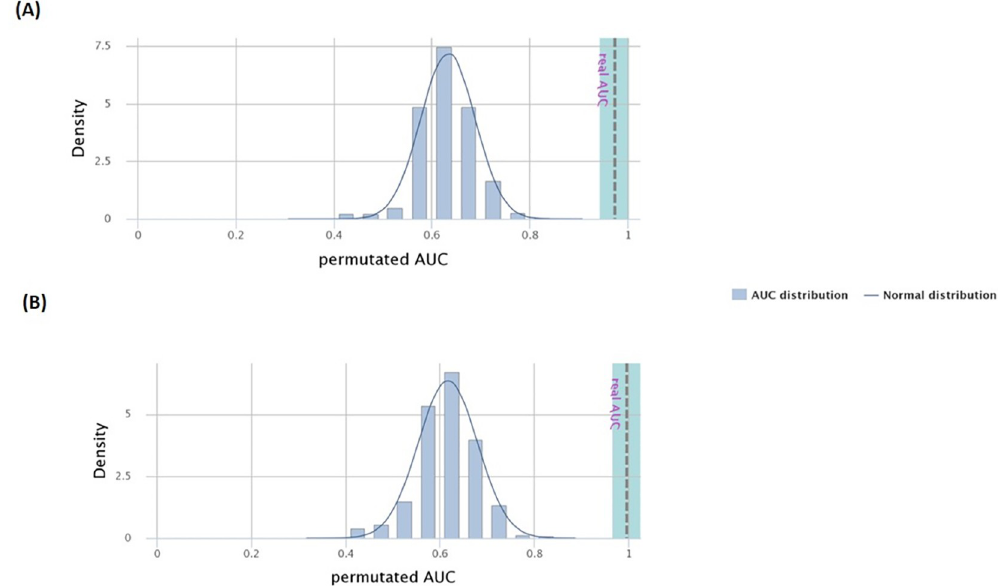
Fig 5. Distribution of the permutated Area under the curves (AUCs) in comparison to normal distribution and the significance of the real AUC for the best performed marker panel of (A) Primary Knee Osteoarthritis (pKOA), (B) Secondary Knee Osteoarthritis (sKOA).